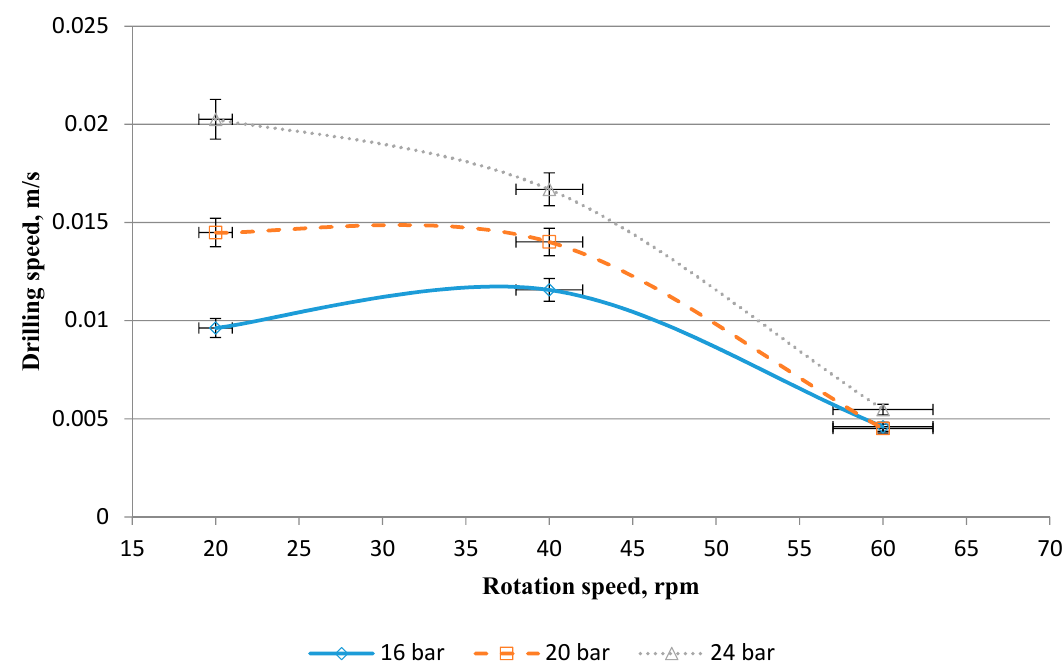
Figure 5. Variation of drilling velocity with rotation speed for several pressures (shown in the legend below the figure), for the 110 mm diameter drill bit, an interval of 54 to 72 m below the ground level, and boreholes 1–3.